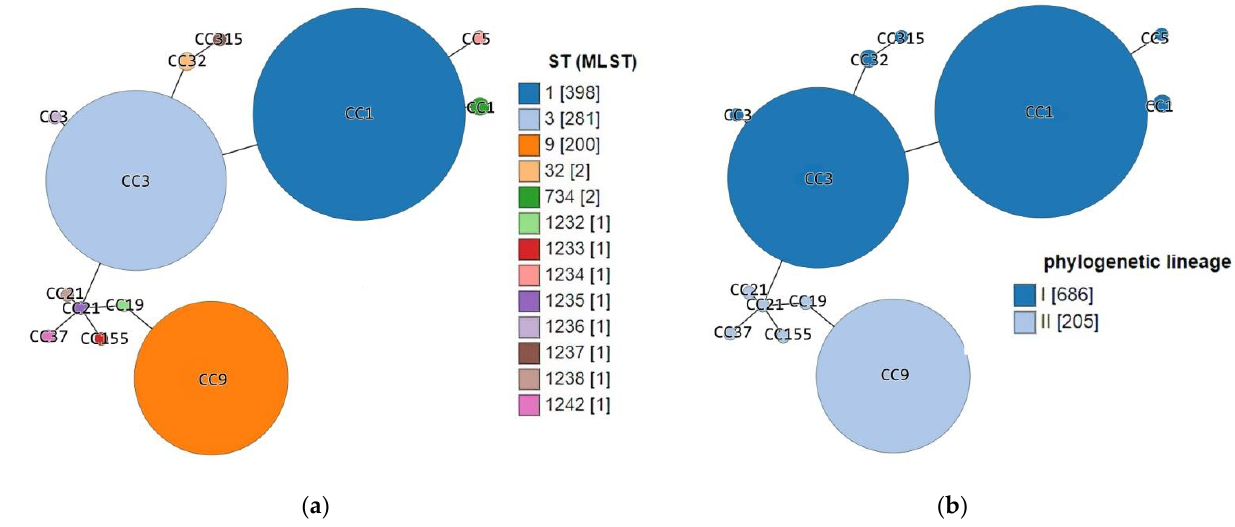
Figure 3. Minimum spanning tree demonstrating the genetic relatedness between L. monocytogenes strains isolated in the Republic of Serbia in 2004–2012 and 2019 and worldwide (only ST1, ST3, ST9, ST32, and ST734 are included). Each individual circle represents either ( a ) single clonal complex CC or ( b ) one sequence type (ST). The circle ’ s sizes are proportional to the number of strains. Links between circles represent the number of allelic mismatches between either ( a ) CCs or ( b ) STs ( Supplemental Data 1 ) .